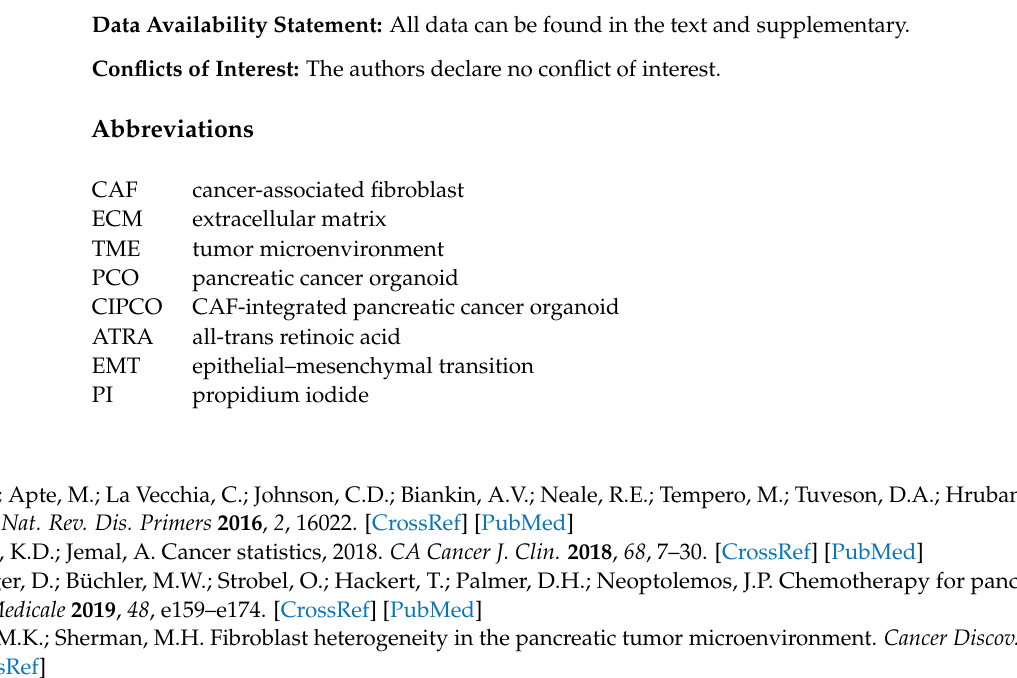
organoid), Table S1: Primer sequences used in this study for qRT-PCR, Table S2: Clinical characteristics of two established organoid